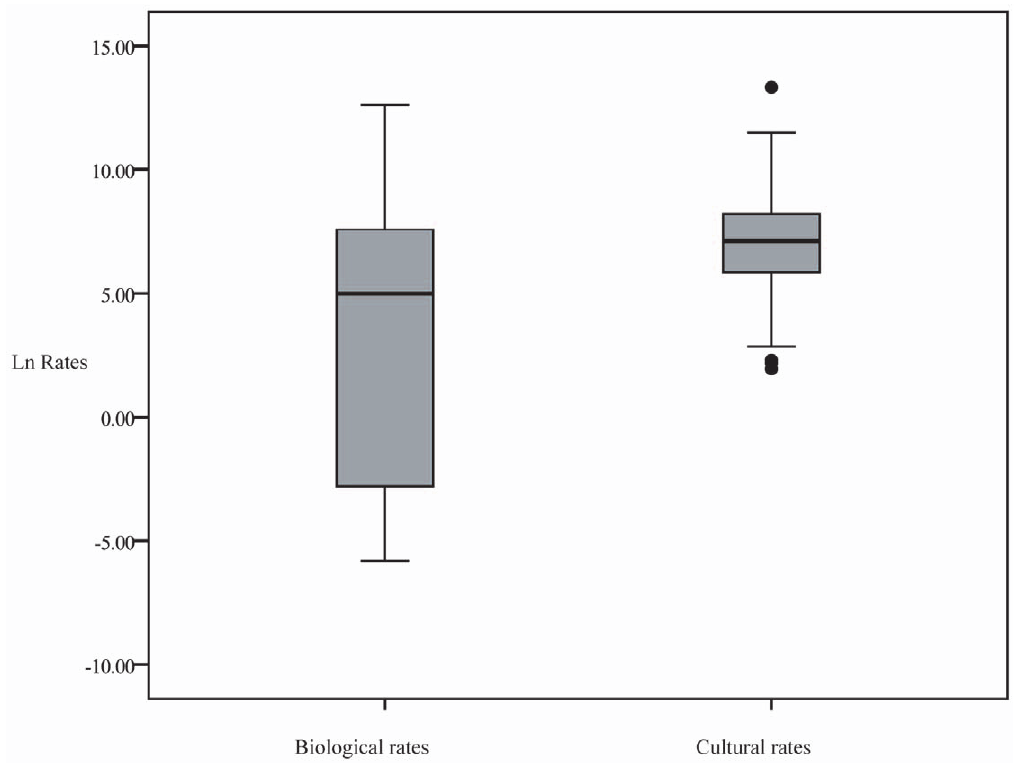
Figure 1. Box-and-whisker plot of the distribution of the absolute values of rates on a natural log scale. On a linear scale, the distribution of biological rates ( n =503) has a mean and standard deviation of 3,187 6 14,457 d , respectively, and a range of 0.003–298,103.5 d . The distribution of cultural rates ( n =573) has a mean of 4,709 6 27,069 d and a range of 7–614,969 d.